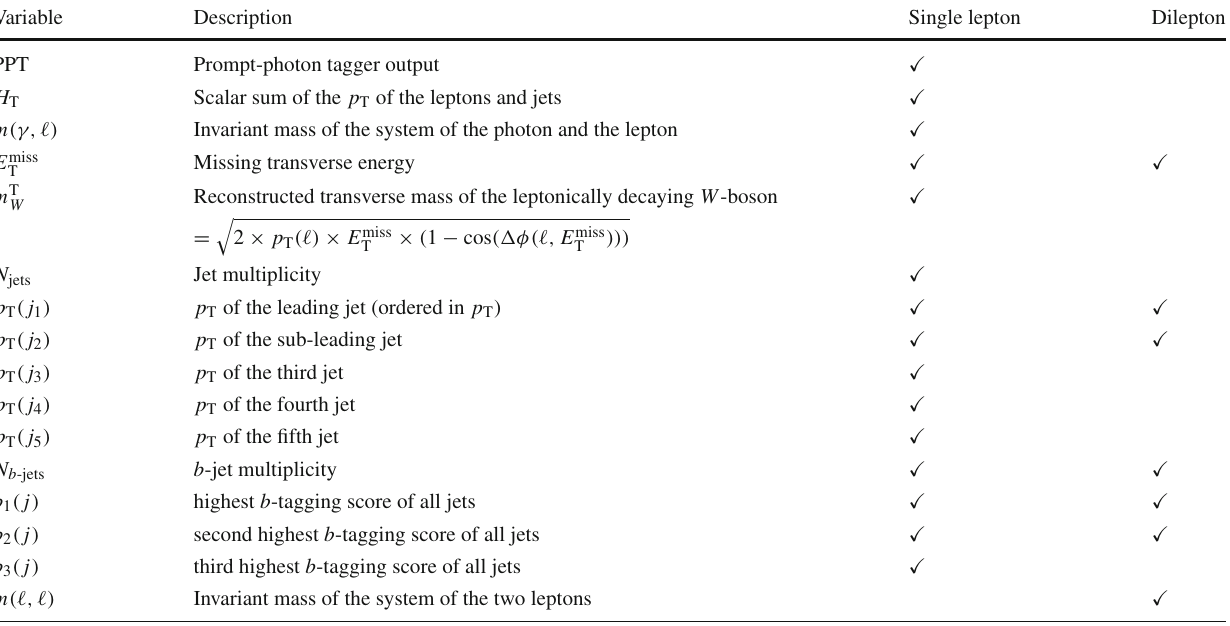
Table 3 Input variables for the event-level discriminator for the single-lepton and dilepton channels. For events without the 5th jet, the p T ( j 5 ) is set to zero